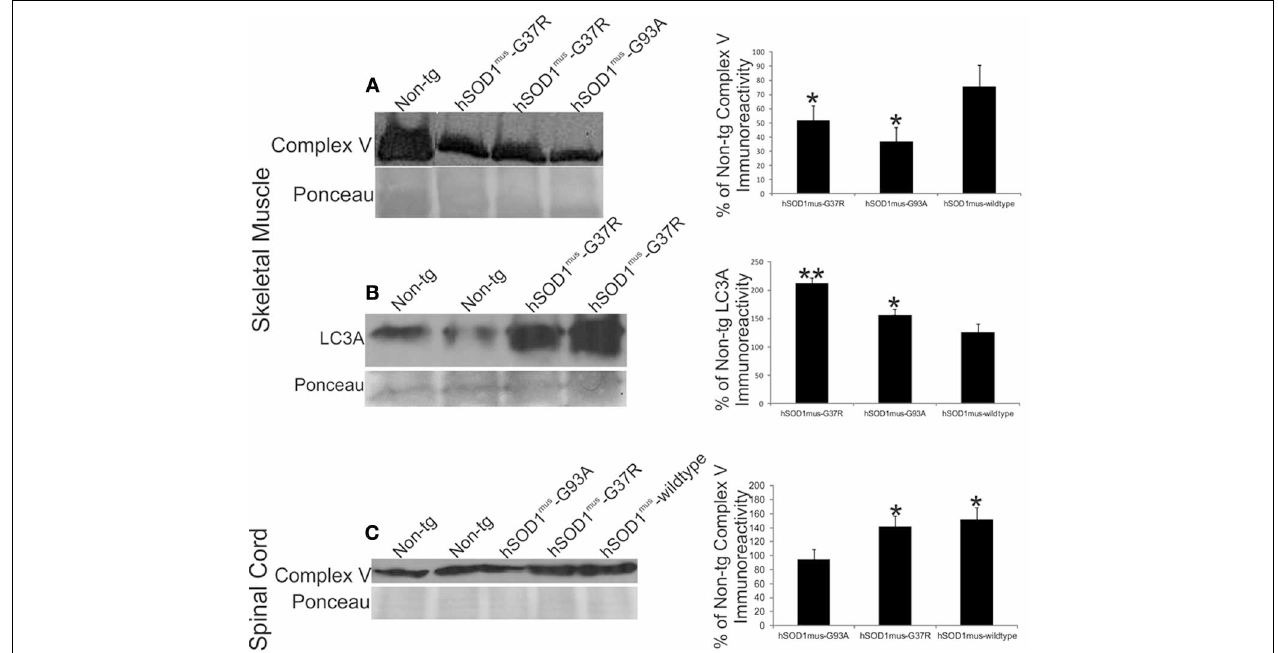
S-stained membrane shows protein loading. Graph (at right) shows the quantification of LC3A immunoreactivity in early symptomatic hSOD1 mus -G37R, hSOD1 mus -G93A, or hSOD1 mus -wildtype tg mice. Values (as % of control) are mean ± SD. Significant differences from non-tg control are indicated by single ( p < 0 . 05) or double ( p < 0 . 01) asterisks. (C) Western blot for complex V in spinal cord crude extracts (50 µ g/lane) of early symptomatic tg mice expressing skeletal muscle-restricted hSOD1 mus -G37R or hSOD1 mus -wildtype. Ponceau S-stained membrane shows protein loading. Graph (at right) shows the quantification of complex V immunoreactivity in spinal cord of early symptomatic hSOD1 mus -G37R, hSOD1 mus -G93A, or hSOD1 mus -wildtype tg mice. Values (as % of control) are mean ± SD. Asterisk denotes significant differences ( p < 0 . 05) from non-tg